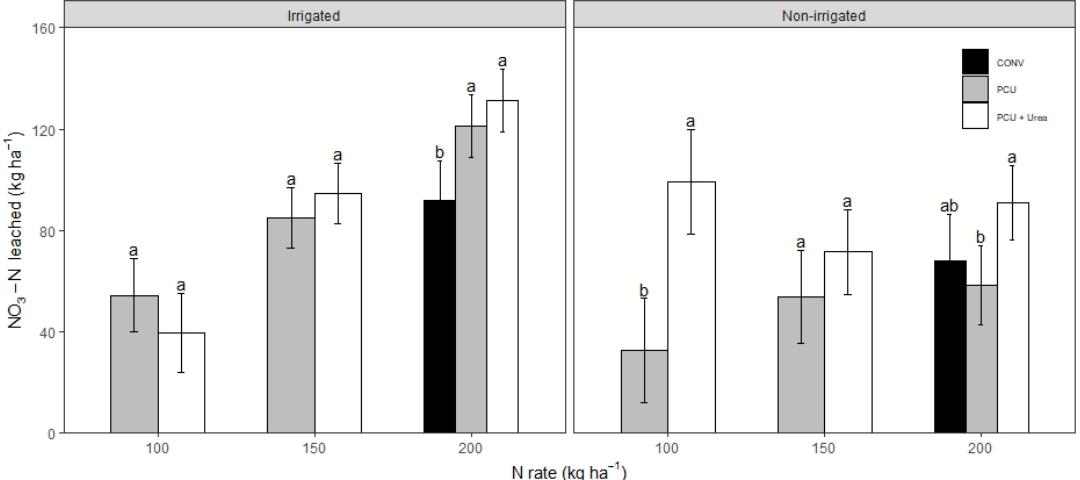
Figure 4. Average seasonal NO 3 − -N leaching in the irrigated and the non-irrigated sites as affected by the fertilizer N source and rate during the 3-year experiment. For a same N rate, the bars topped with same letters are not significantly different at p = 0.05 probability level. CONV, conventional nitrogen management in Quebec consisting of a split application of 200 kg N ha − 1 as a mixture of 50% ammonium sulfate at planting and 50% calcium ammonium nitrate at hilling; PCU, polymer-coated urea applied at planting at three different N rates (100, 150, and 200 kg N ha − 1 ); PCU + urea, a mixture of 75% PCU + 25% urea banded at planting at three different N rates (100, 150, and 200 kg N ha − 1 ).